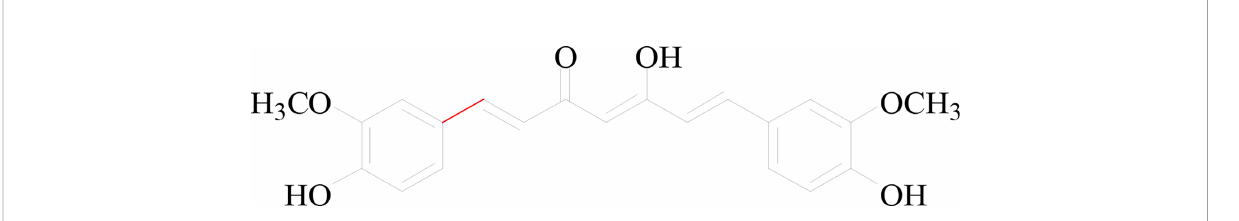
FIGURE 1 The chemical structure of curcumin. This study aimed to use bibliometric methods and visual analysis to identify research trends and potential hot spots of the application of curcumin in tumor by comprehensive analysis of relevant information of publications published worldwide